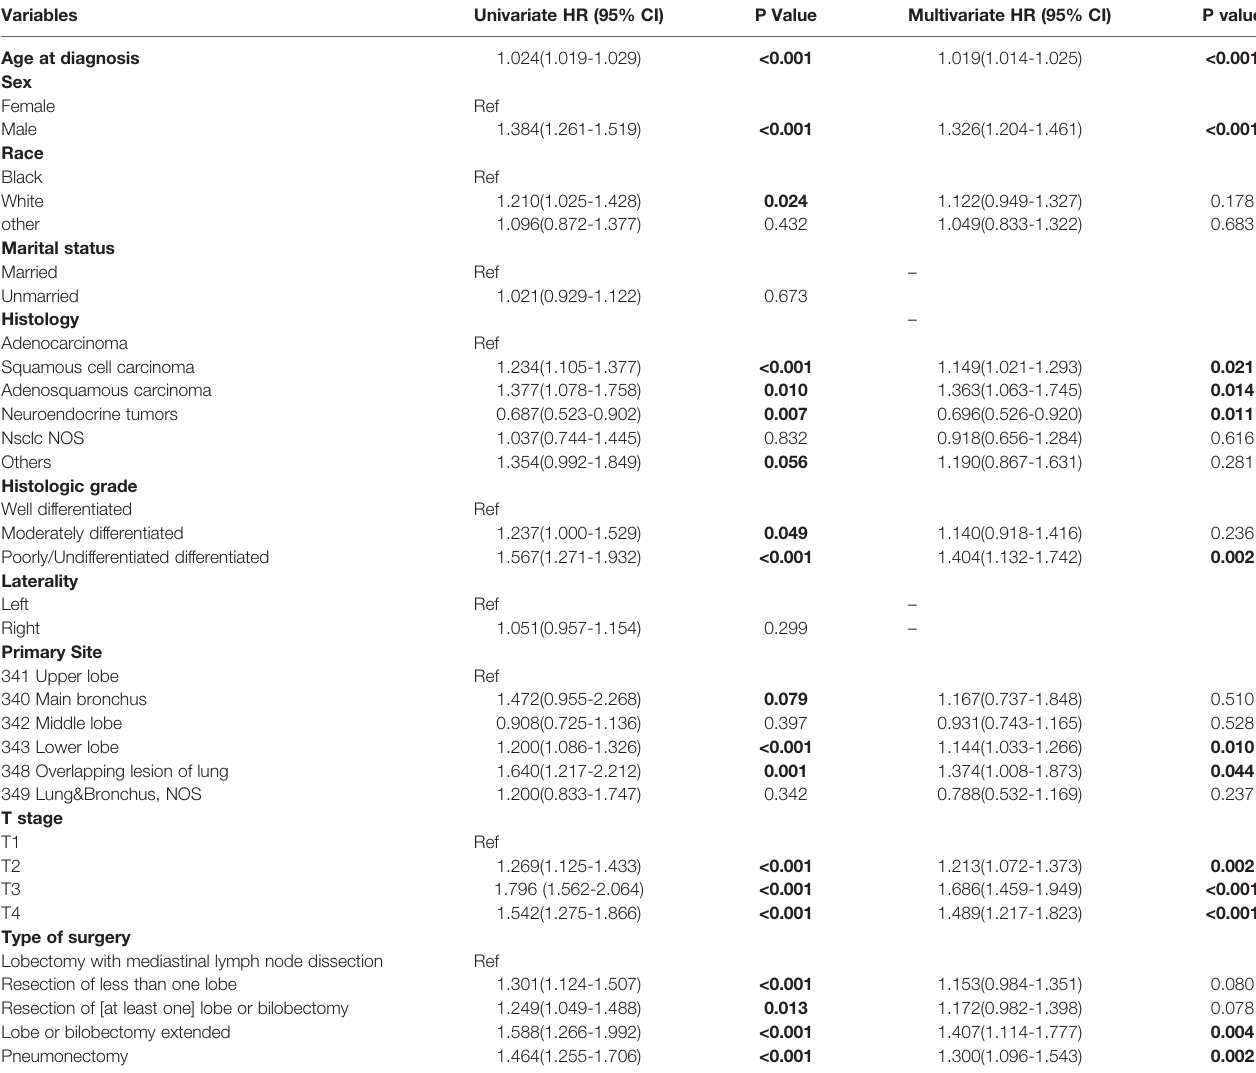
TABLE 2 | Cox regression analysis of overall survival of patients underwent surgery with pN2 in SEER